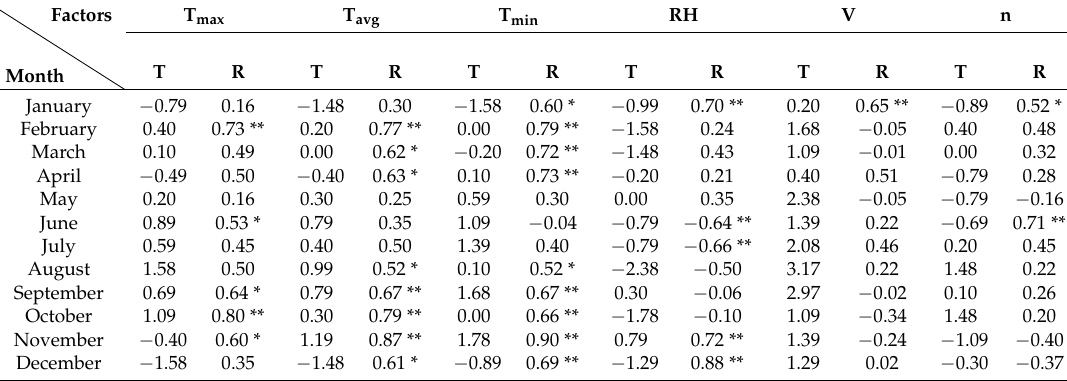
Table 3. Meteorological factors trend (T) and correlation coefficients (R) with ET in the PRB.